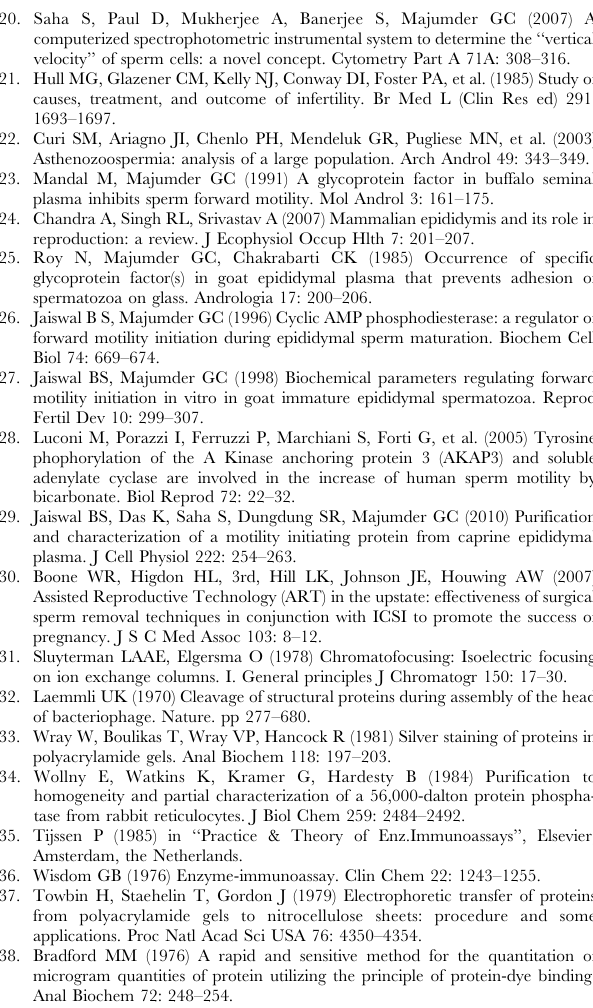
Figure S2 Protein specificity of MIF-II action. Among BSA (66 kDa), caprine IgG (150 kDa) and MIF-II (160 kDa), only MIF-II showed forward motility inhibition of spermatozoa. Found at: doi:10.1371/journal.pone.0012039.s002 (0.17 MB